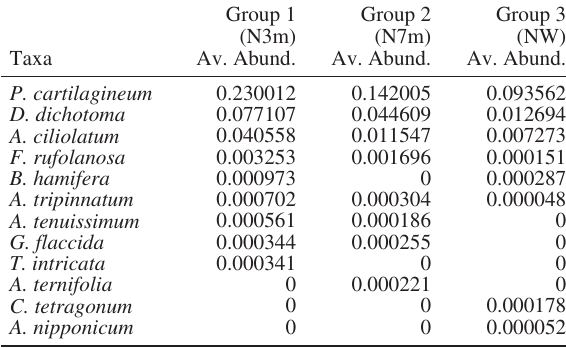
Table 5. – Average abundance (epiphytes/ G. corneum biomass ra- tios) of each taxon in the different groups (Group 1, Group 2, Group 3). Taxa are arranged by